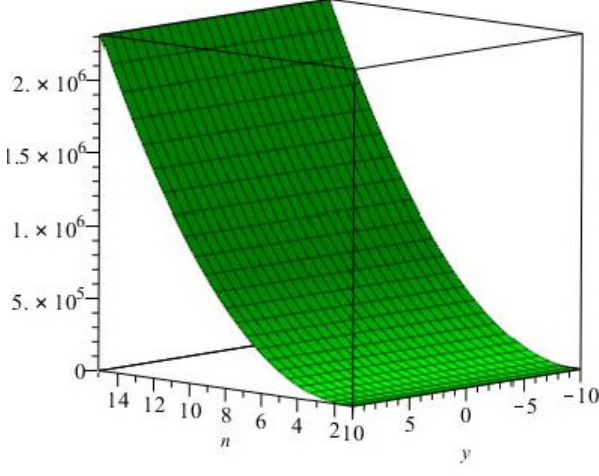
Figure 3. The graphical representation of the Eccentric-connectivity